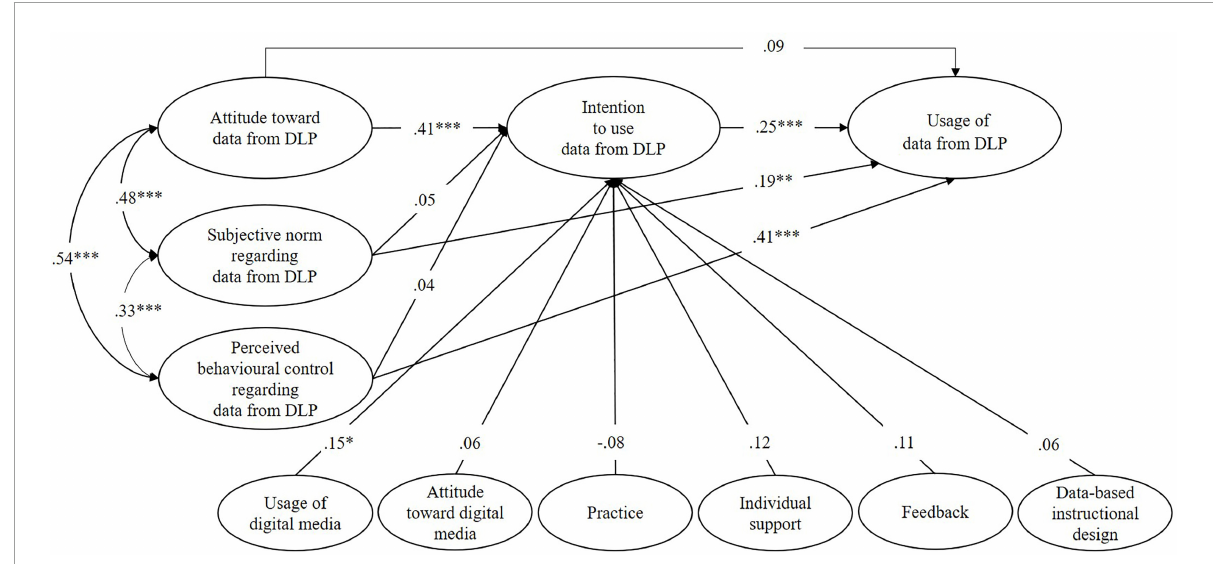
FIGURE4 Results of the structural equation modeling (SEM) for the extended theory of planned behavior (TPB) model in case of data from digital learning platforms (DLP). N = 272; ∗ p < 0.05, ∗∗ p < 0.01, and ∗∗∗ p < 0.001.